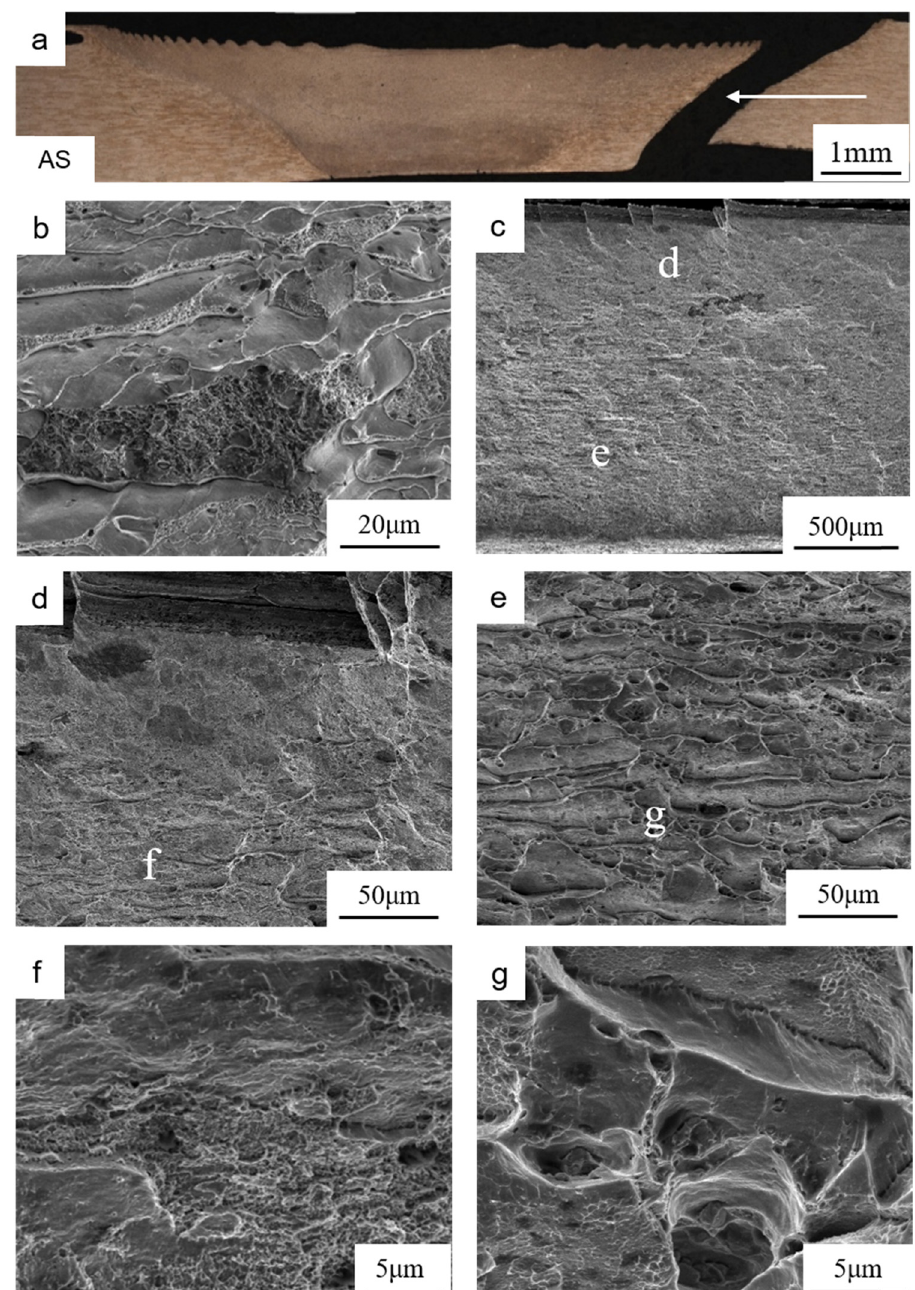
Figure 10: ( a ) OM of as - tested A2 specimen and observation direction of SEM indicated by white arrow; ( b ) SEM of the fracture surface of the as - tested base material specimen; SEM of ( c ) fracture surface of as - tested A2 specimen, ( d and e ) local zone in ( c ) , ( f ) local zone in ( d ) , and ( g ) local zone in ( e )